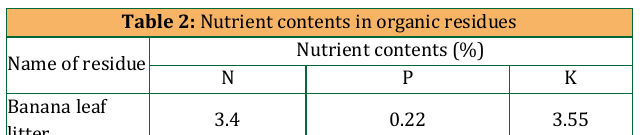
Table 2: Weather data regarding monthly average air temperature, rainfall, relative humidity and sunshine hours day -1 at the experimental